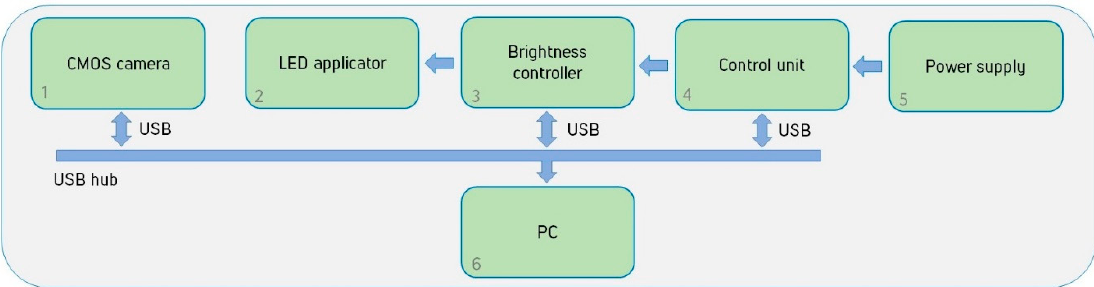
( b ) Figure 9. Dependence of the change in the total flux (power) of radiation coming to the camera detector on the change in the hypodermis thickness and on the presence of pathology in the sinuses of female ( a ) and males ( b ) for wavelengths of 650 and 850 nm. The following labels are used: “N” for healthy tissues, “C” for tissues with cyst, and “T” for tissues with